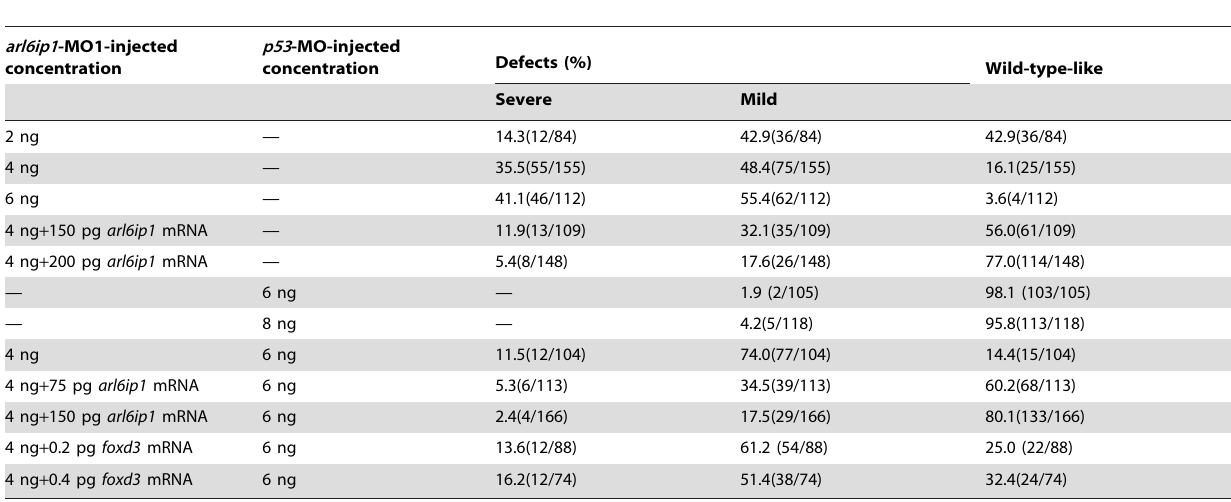
Table 1. Injection of wobble arl6ip1 mRNA enables embryos to rescue the defects induced by injection of arl6ip1 -MO1/ p53 -MO.